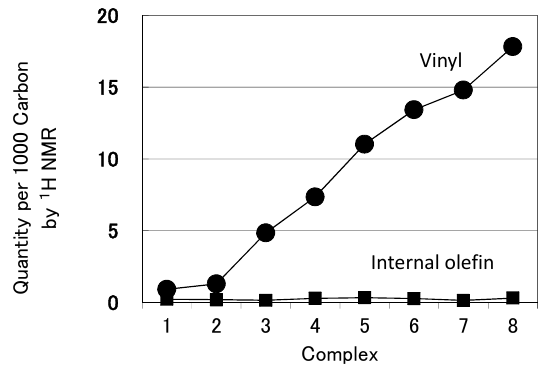
Figure 3. Quantity of vinyl groups and internal olefins (per 1000 carbon calculated by 1 H-NMR) in ethylene/butadiene copolymerization by complexes 1 – 8 / i Bu Polymerization conditions refer to entries 1 – 8 in Table 1.